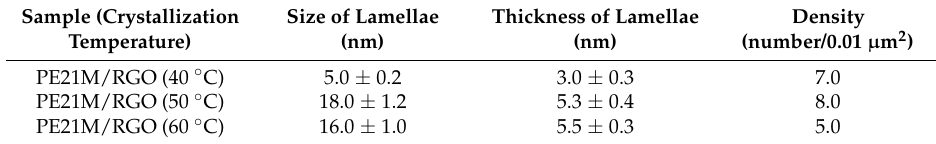
Table 3. The average size of PE21M lamella formed on RGO based on the TEM images of 200 lamellae.